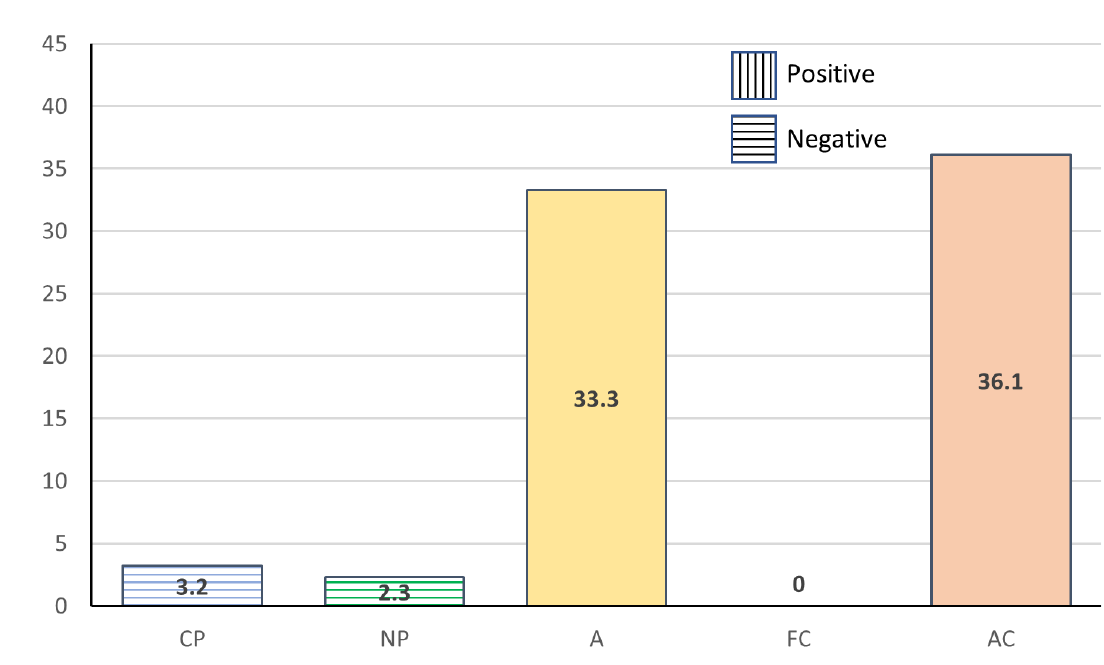
Figure 4: Non-Alcoholic Suicide